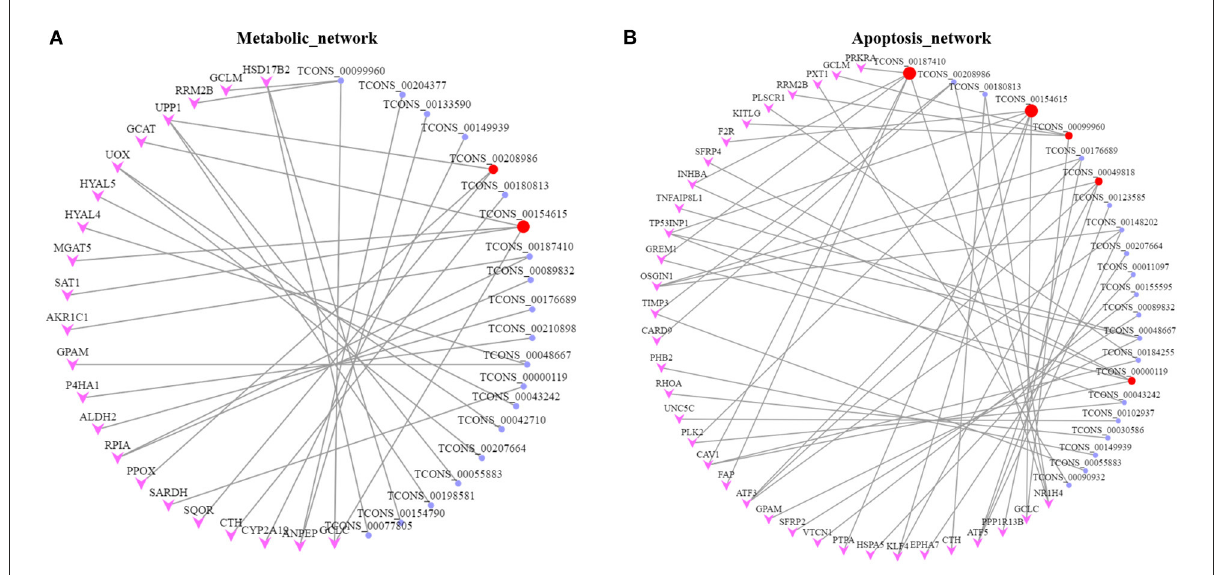
FIGURE7 Networks for lncRNA-mRNA interaction. (A) lncRNA-mRNA network for Metabolic. (B) lncRNA-mRNA network for Apoptosis. The target genes and lncRNAs colored in pink and purple, respectively. Key lncRNAs are colored in